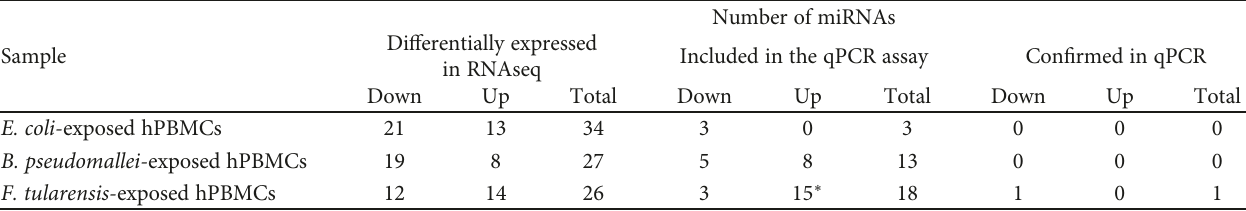
Table 2: Summary table of the number of miRNAs di ff erentially expressed in RNAseq, included in the qPCR assay, and con fi rmed in qPCR. Number of miRNAs Di ff erentially expressed Included in the qPCR assay Con fi rmed in qPCR Sample in RNAseq Down Up Total Down Up Total Down Up